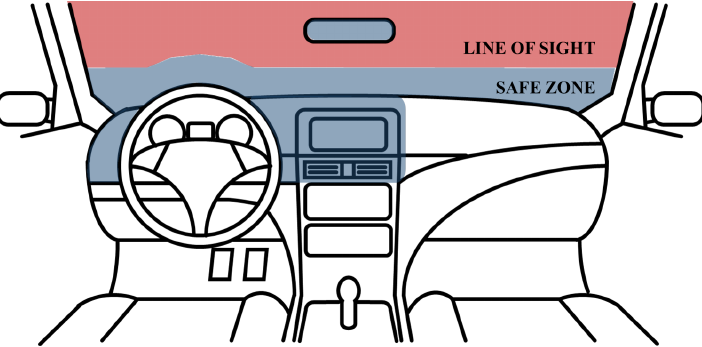
Figure 1. “Safe zone” and “line of sight” in the Anti-Distracted Driving